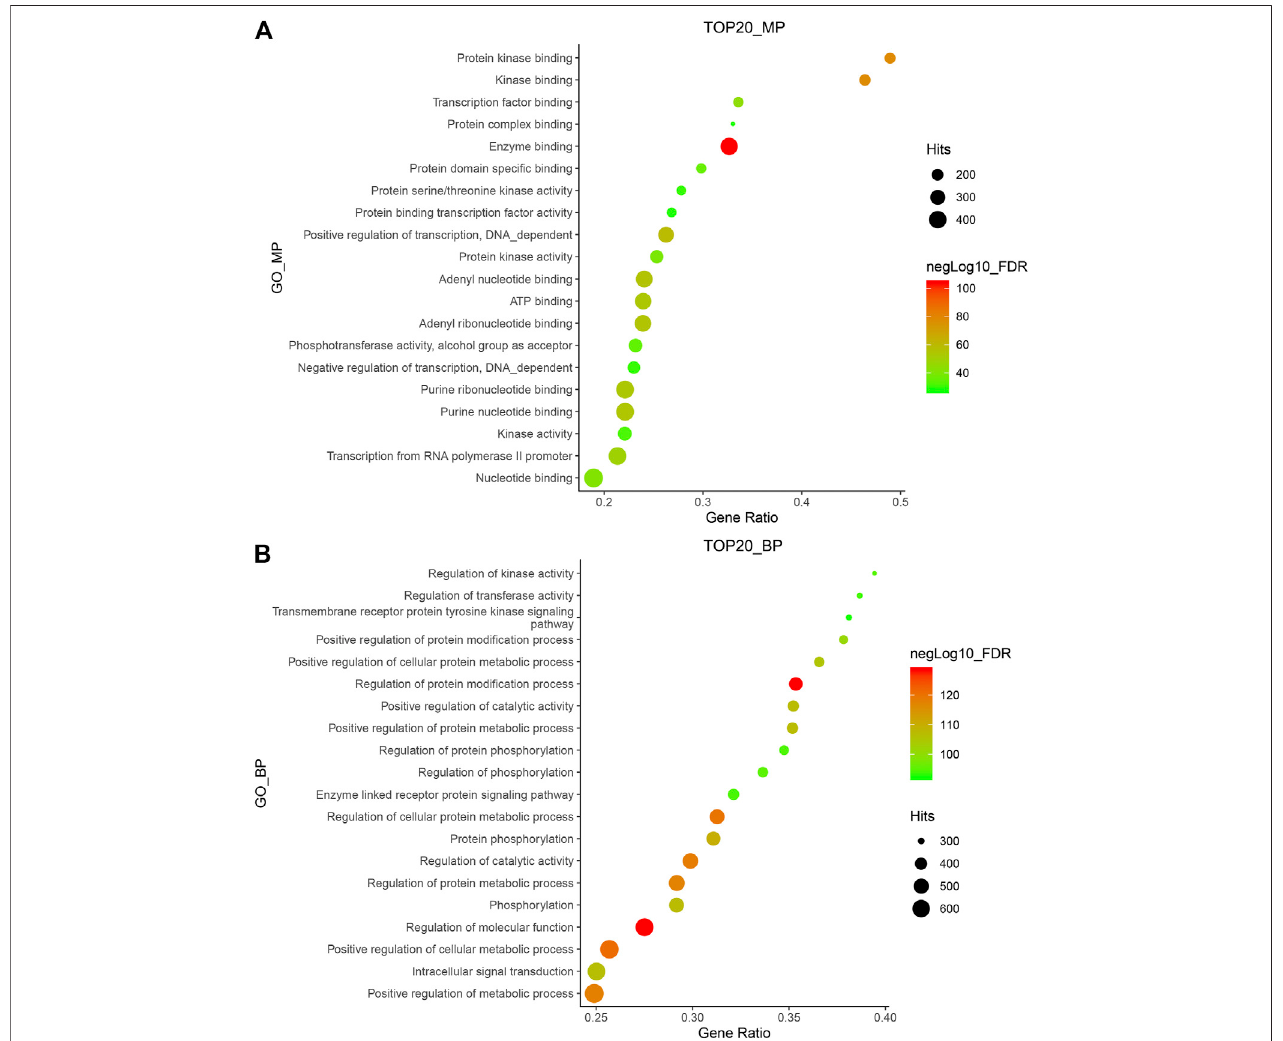
FIGURE 1 | GO_MP (A) and GO_BP (B) enrichment of Hansenia weberbaueriana . The x -axis displays as gene ratio (Hits/Total) and the y -axis represents the GO_MP/B p terms. The intensity of the color depends on the − log10(FDR) and red means a higher signi fi cant difference. The size of the point shows the number of Hits.